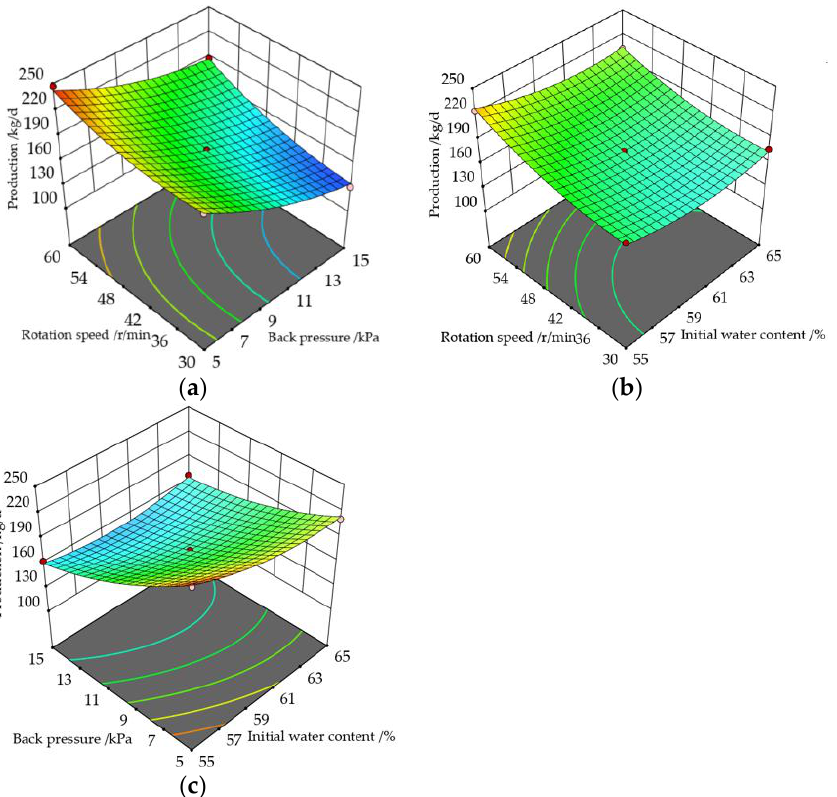
Figure 11. Relationship between production and interactive factors. ( a ) Interaction between rotation speed and back pressure. ( b ) Interaction between rotation speed and initial water content. ( c ) Interaction between back pressure and initial water content.